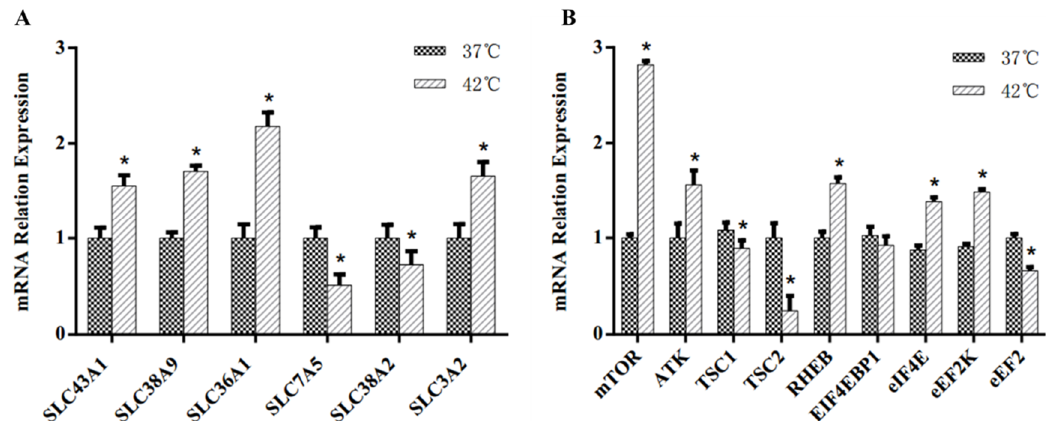
Figure 5. Effects of heat stress on mRNA expression of amino acid transporter and key regulator genes at mTOR signaling pathway in MAC-T bovine mammary epithelial cell line cultured at 42 ◦ C. ( A ) The mRNA expression of amino acid transporter genes. ( B ) The mRNA relation expression of key regulator genes at mTOR signaling pathway. Asterisks indicate significant differences between different groups: * p < 0.05.